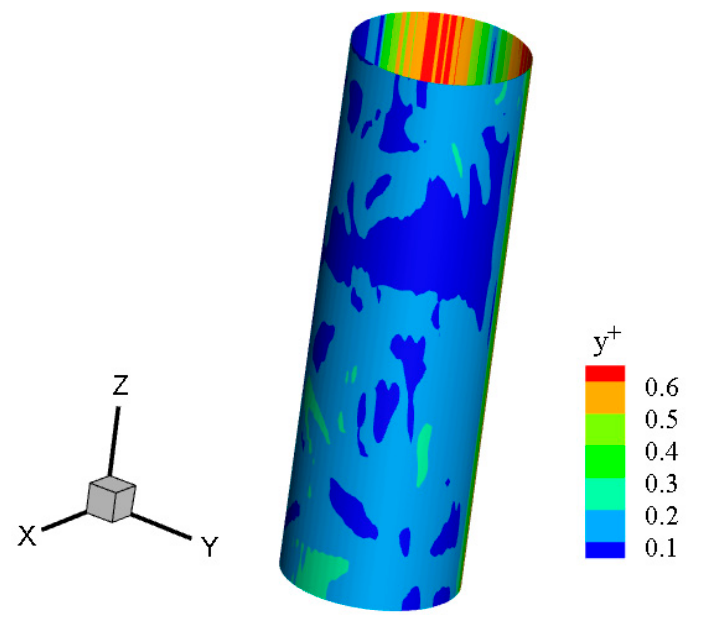
Figure 3. y + distribution of wall surface of bare cylinder.